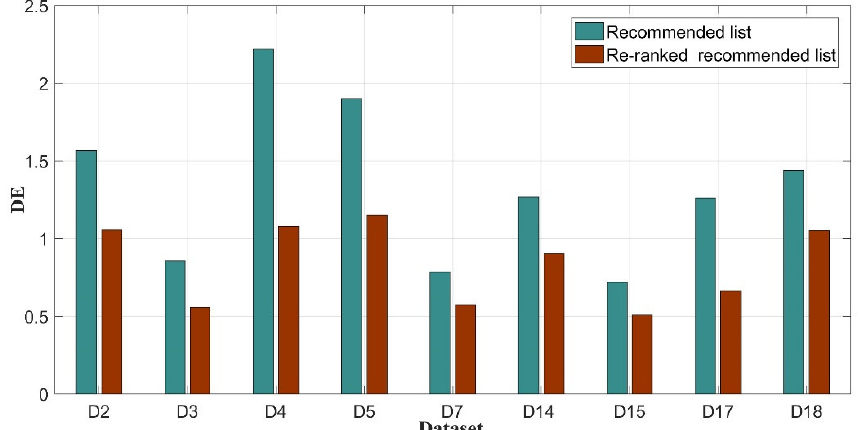
Figure 10. DE of two recommended lists. Sensors 2020 , 20 , x